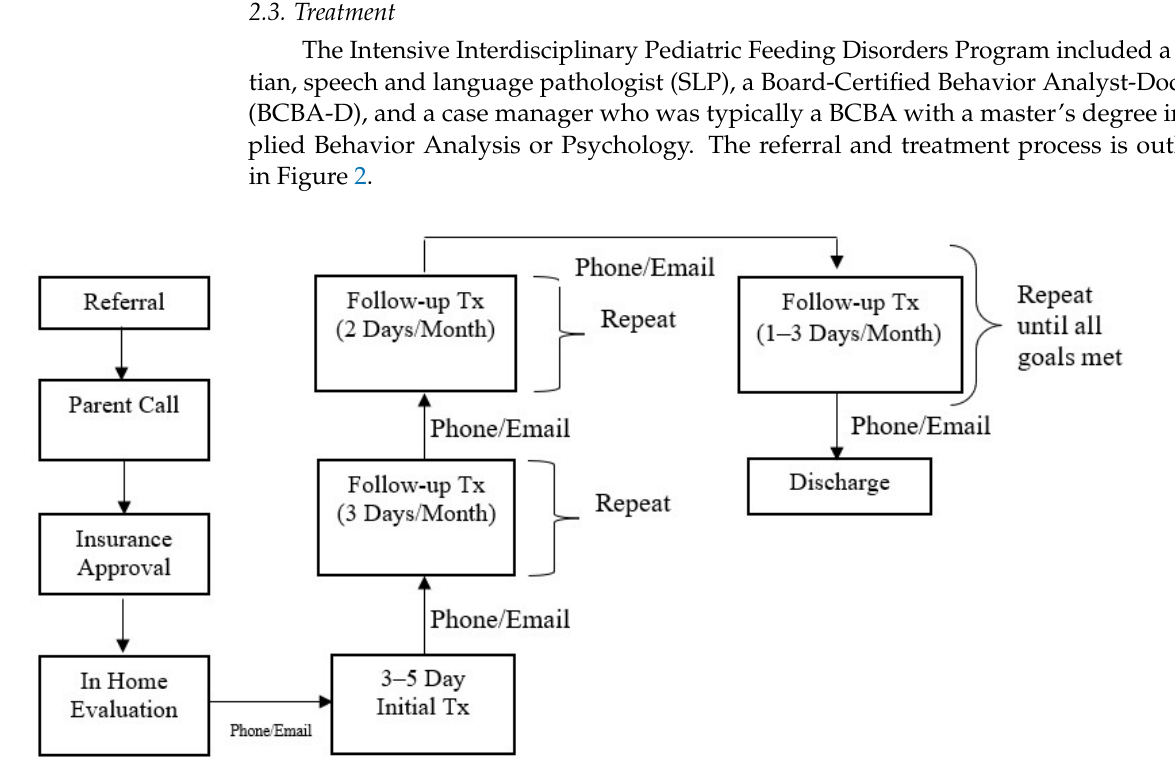
Figure 2. Referral and Treatment Process.